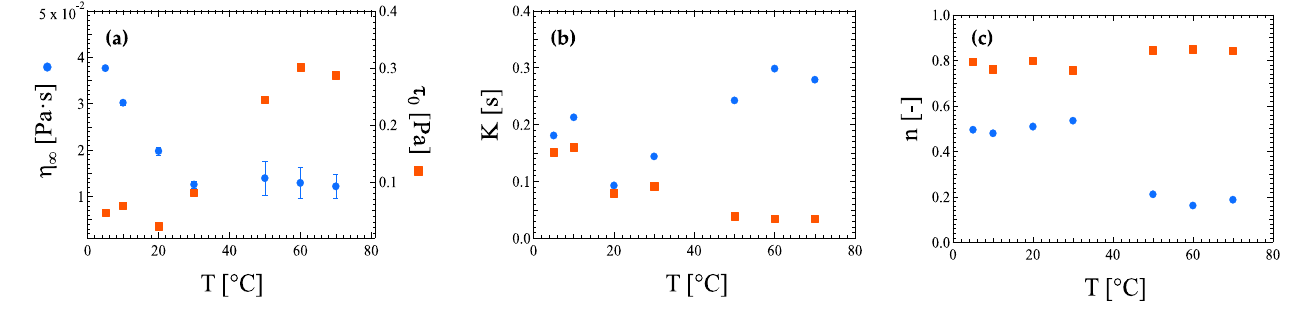
Figure 7. Comparison between Sisko equation (circle) and Herschel–Bulkley model (square) fitting parameters with error bars of ( a ) infinity-shear viscosity η ∞ and zero-shear stress τ 0 , ( b ) flow consistency index K , and ( c ) flow behavior index n for ink suspensions with 0.40 wt% HRCM load. Both models, the Sisko and Herschel–Bulkley equations, were used to fit flow curve data as a function of the temperature of ink suspensions with 0.80 wt% HRCM load as well (Appendix B—Tables A6 and A7). The comparison of the two models is shown in